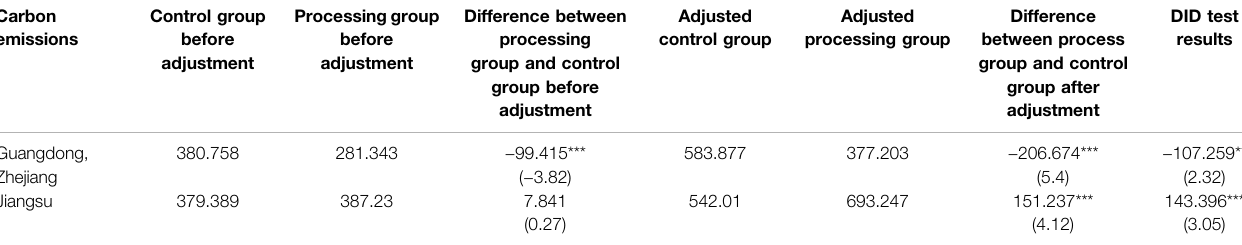
TABLE 5 | PSM-DID robustness